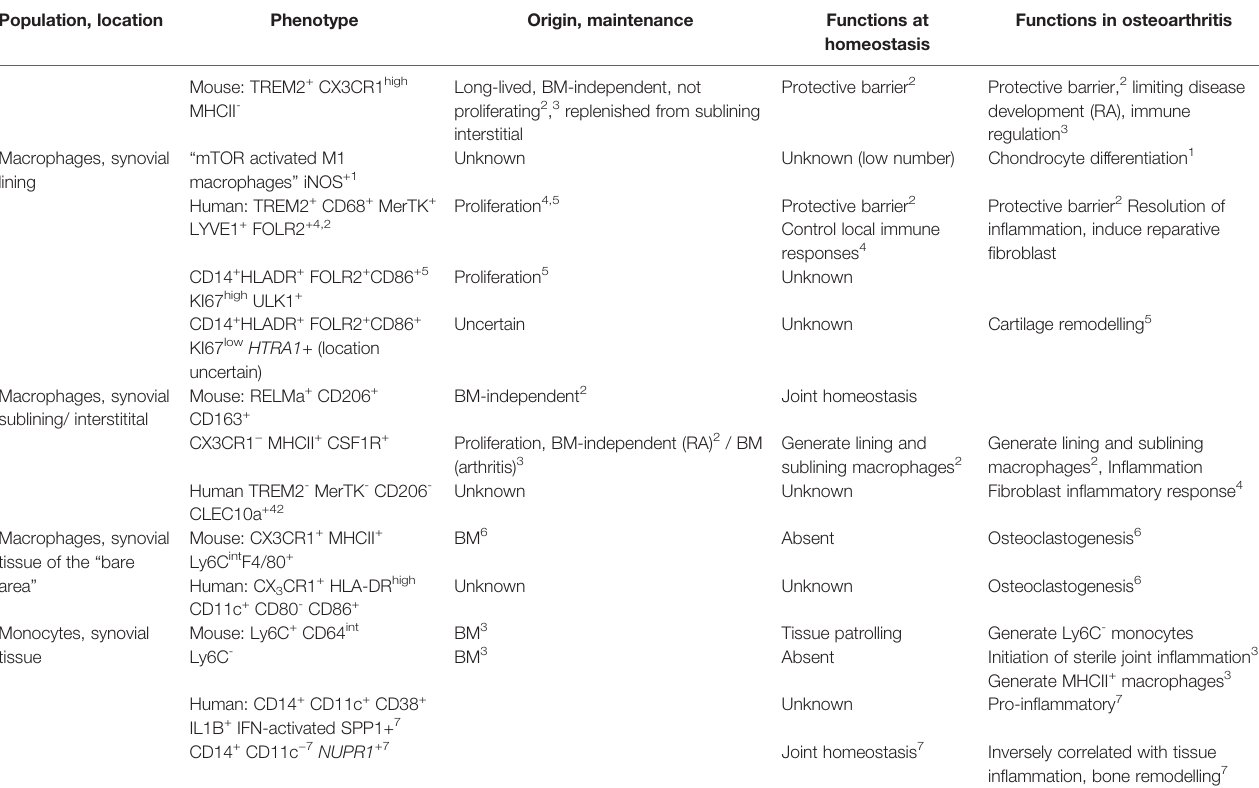
TABLE 1 | Markers, origin and putative function of monocytes and synovial macrophage subsets in mouse and human. Population,